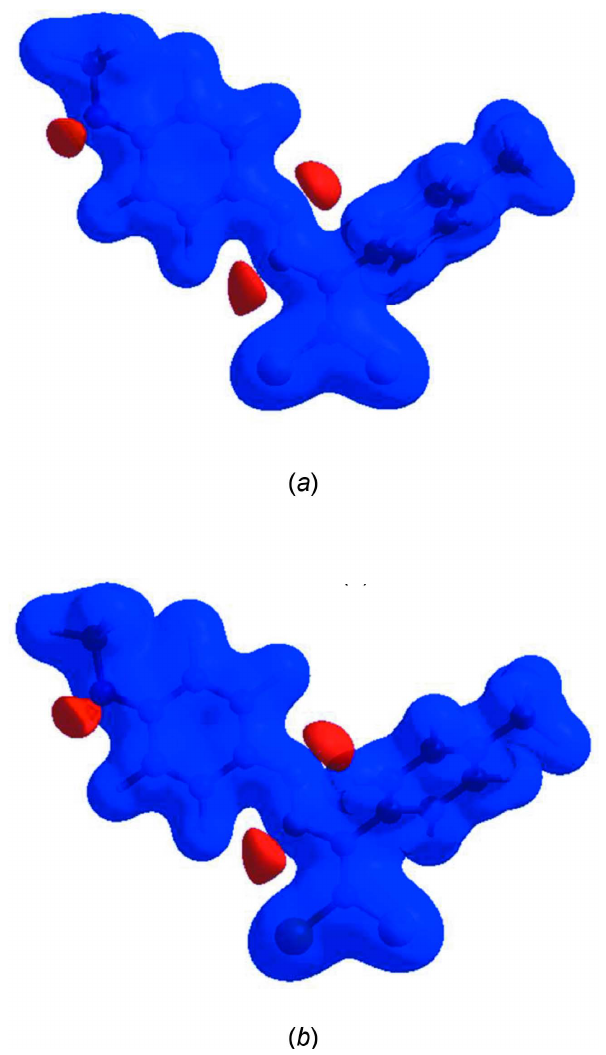
Figure 5 Views of the three-dimensional Hirshfeld surfaces of ( a ) molecule A and ( b ) molecule B plotted over electrostatic potential energy in the range (cid:5) 0.0500 to 0.0500 a.u. using the STO-3 G basis set at the Hartree–Fock level of theory. The hydrogen-bond donors and acceptors are shown as blue and red regions, respectively, around the atoms corresponding to positive and negative potentials.